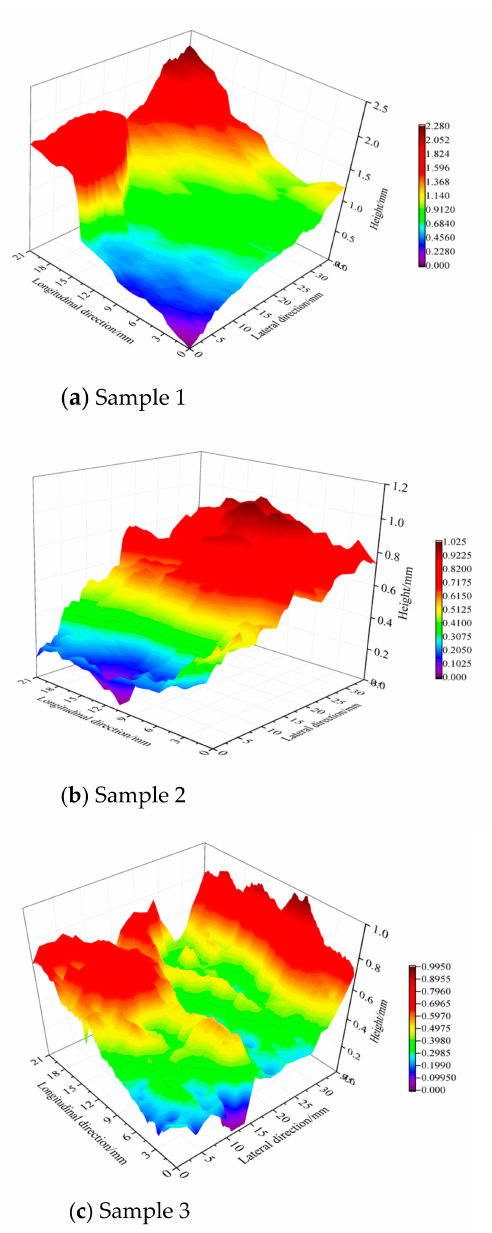
Figure 3. Shale fracture surface morphologies (the subfigures ( a – c ) are the reconstructed images of the rectangular region with 35 mm length and 21 mm width on the three shale surface morphology, and they are the zone for the calculation of characteristics